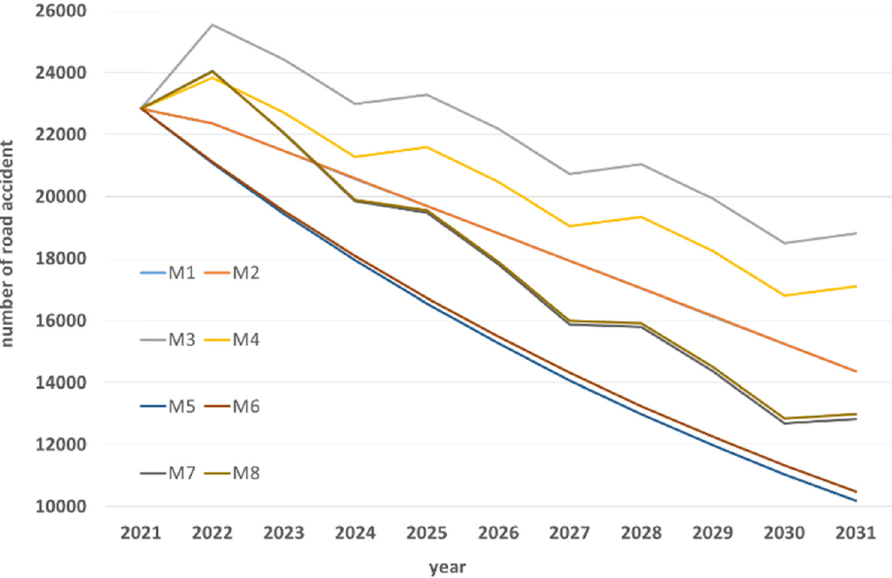
Figure 4: Forecasting the number of road accidents in Poland in 2022 – 2031 ( M1 – linear Holt model – MPE; M2 – linear Holt model – SSE; M3 – linear additive model – MPE; M4 – linear additive model – SSE; M5 – exponential model – MPE; M6 – exponential model – SSE; M7 – additive exponential model – MPE; and M8 – additive exponential model – SSE )